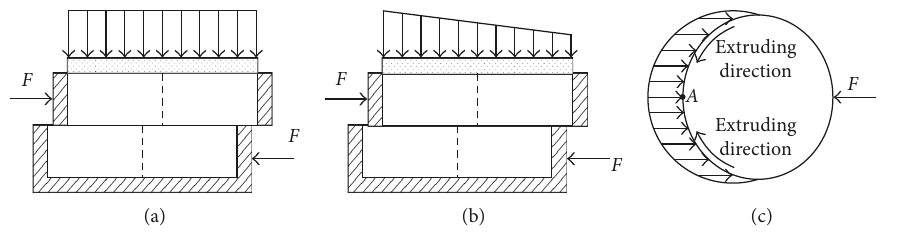
Figure 10: The influence of direct shear experiment on failure modes of discontinuity. (a) Initial state; (b) stress redistribution; (c) stress